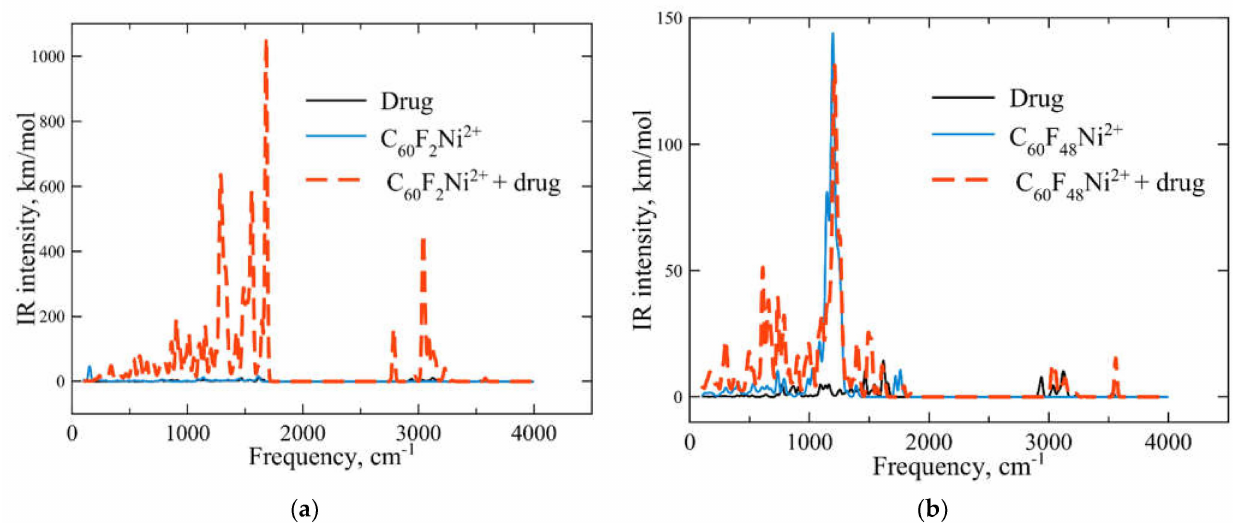
Figure 6. Infrared spectra of ( a ) chloroquine drug (black line), C 60 F 2 Ni 2+ carrier (blue line) and carrier + loaded drug complex (red dashed line). ( b ) The same spectra for high-fluorinated C 60 F 48 Ni 2+ carrier loaded with chloroquine. The calculated wavelengths corresponding to the transitions are broadened by Gaussian curves with σ = 10 cm − 1